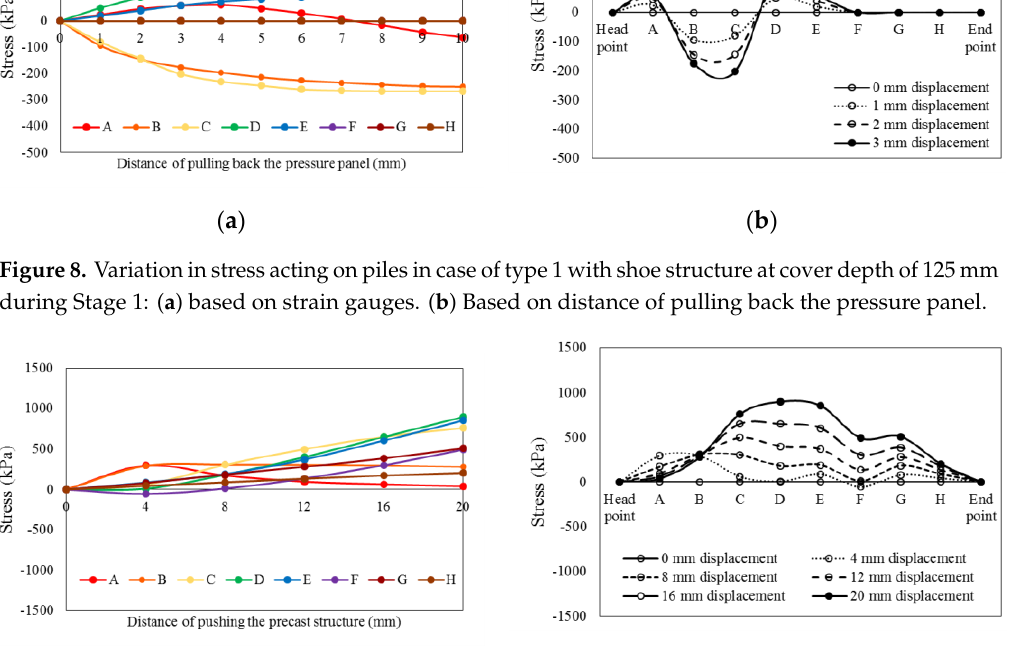
Figure 9. Variation in stress acting on piles in case of type 1 with shoe structure at cover depth of 125 mm during Stage 2: ( a ) based on strain gauges. ( b ) Based on distance of propelling the precast structure.